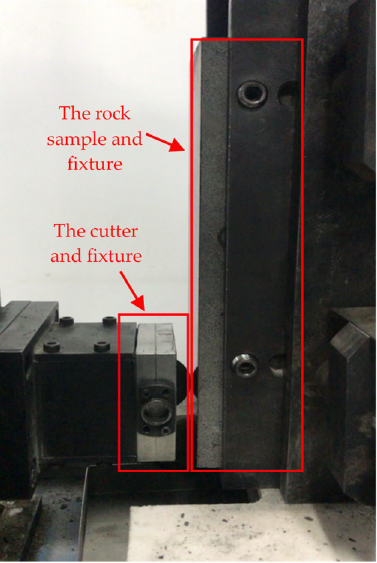
Figure 5. The abrasion process of the reduced-scale cu tt er.